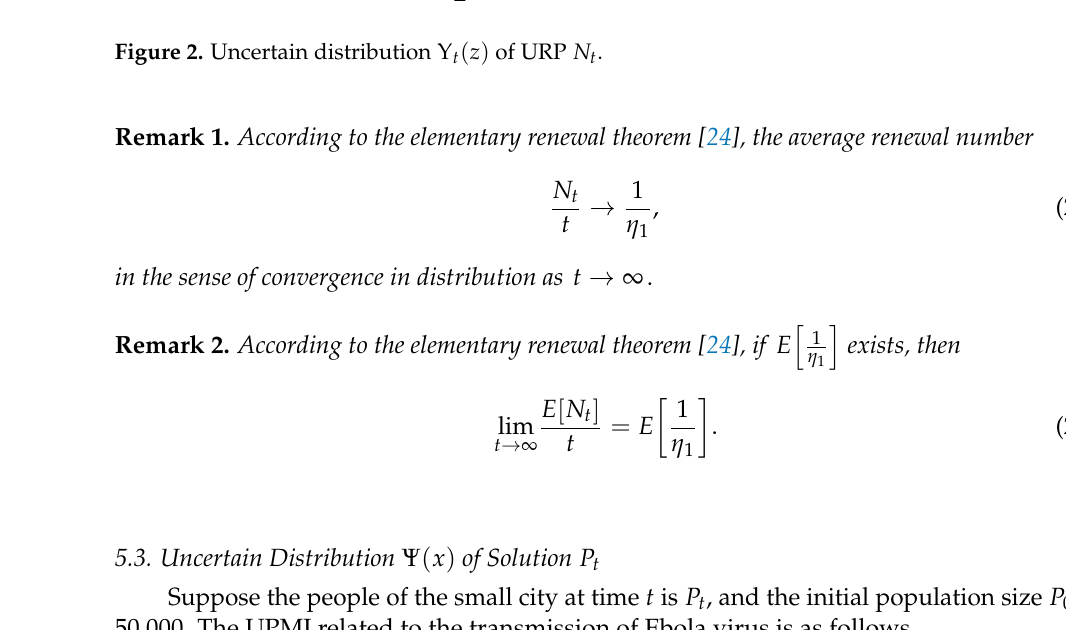
Figure 2. Uncertain distribution ( )